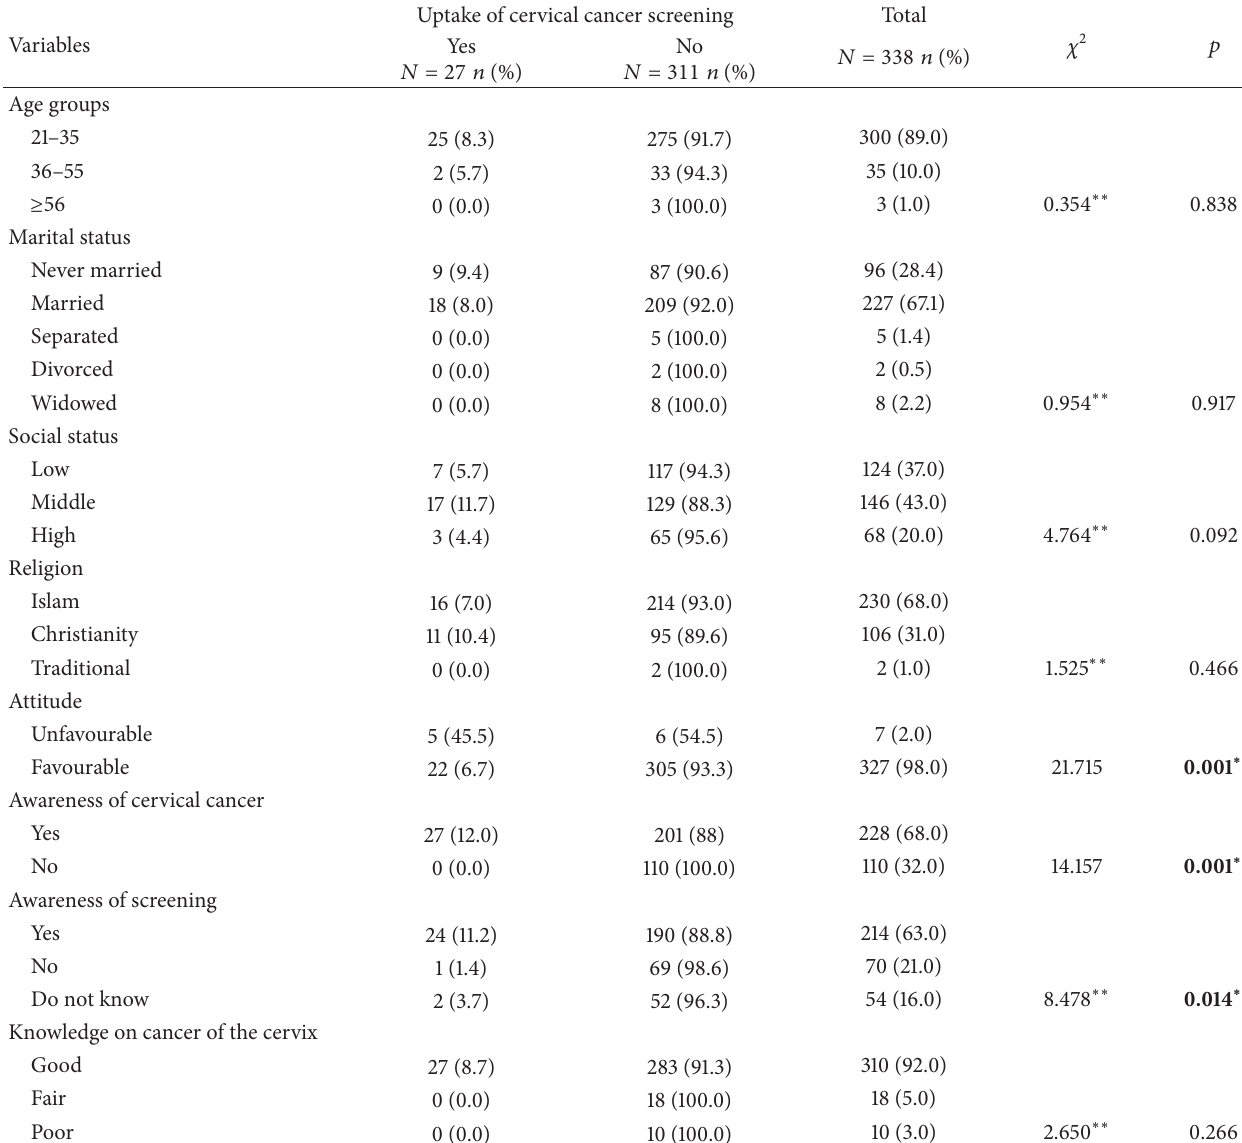
Table 3: Association between respondents’ characteristics and uptake of cervical cancer